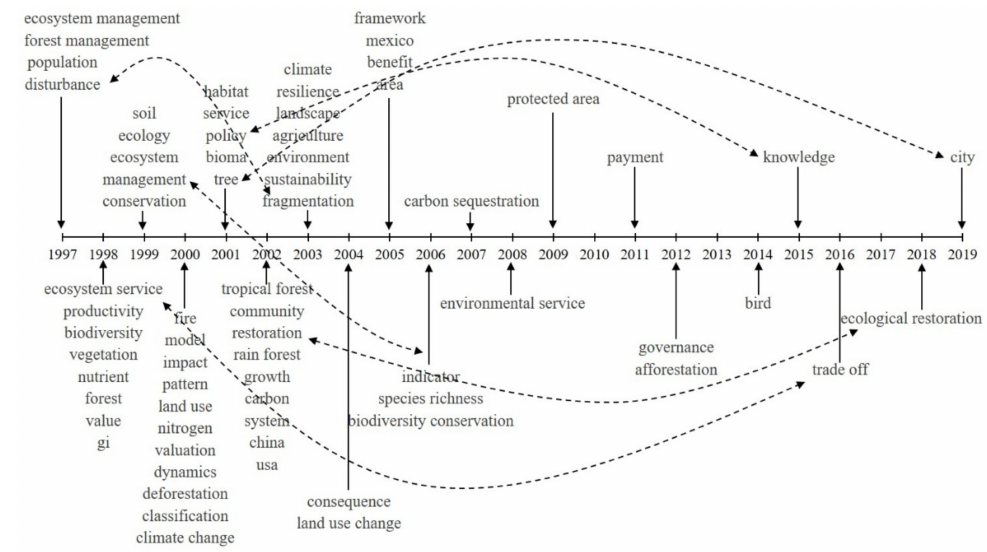
Figure 4. Graphical representation of time series of the top 20 keywords used in published articles on FES-related topics from 1997 to